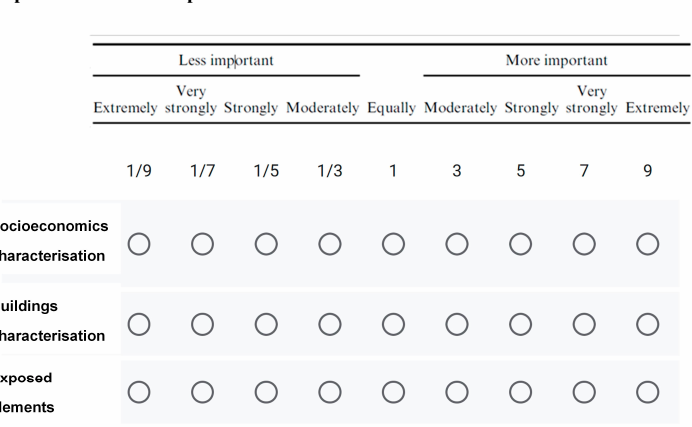
Table 2. Saaty’s scale for weight assignment adapted from [15] .